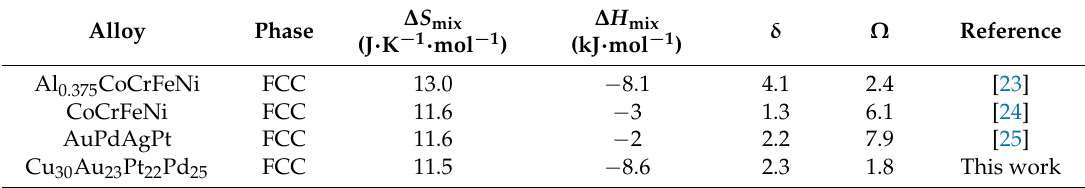
Table 1. Calculated parameters of the quasi-HEA microspheres and other reported HEAs.